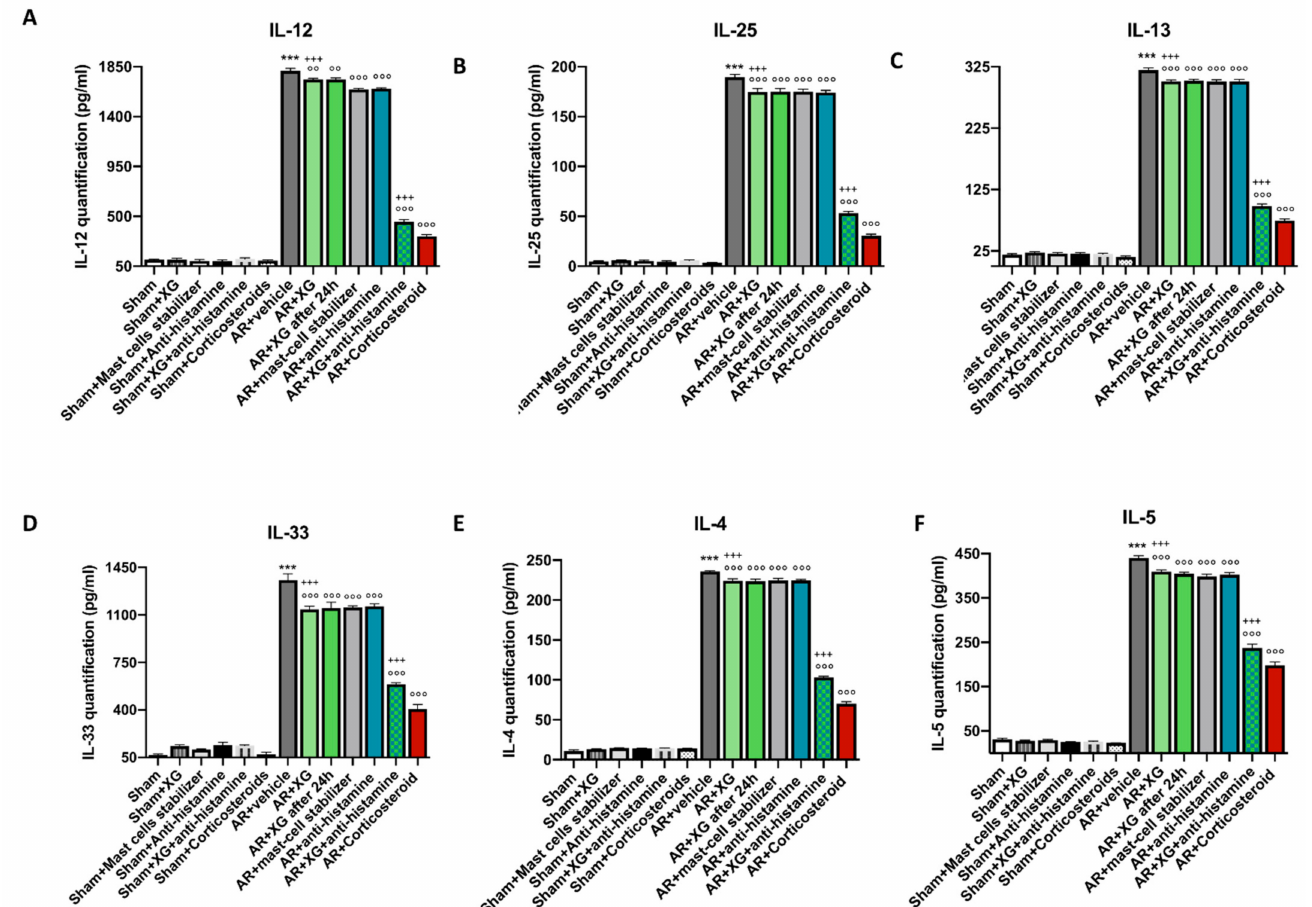
Figure 4. Effect of xyloglucan on cytokine quantification in the BALF of OVA-sensitized mice. OVA-sensitized mice exposed an extensive upregulation of cytokines in the BALF, compared to the sham groups ( A – F ). However, treatment with XG-based spray proved to be successful in reducing the expression of proinflammatory cytokines IL-12, IL-25, IL-13, IL-33, IL-4 and IL-5 in BALF of mice ( A – F ). This decrease was quantitatively greater when XG spray was associated with antihistamine, thus becoming comparable to the effects obtained with corticosteroid administration. Data are representative of at least three independent experiments. Values are means ± SEM. One-Way ANOVA test. *** p < 0.001 vs. Sham; ◦◦ p < 0.01 vs. AR + vehicle; ◦◦◦ p < 0.001 vs. AR + vehicle; +++ p 0.001 vs. AR +